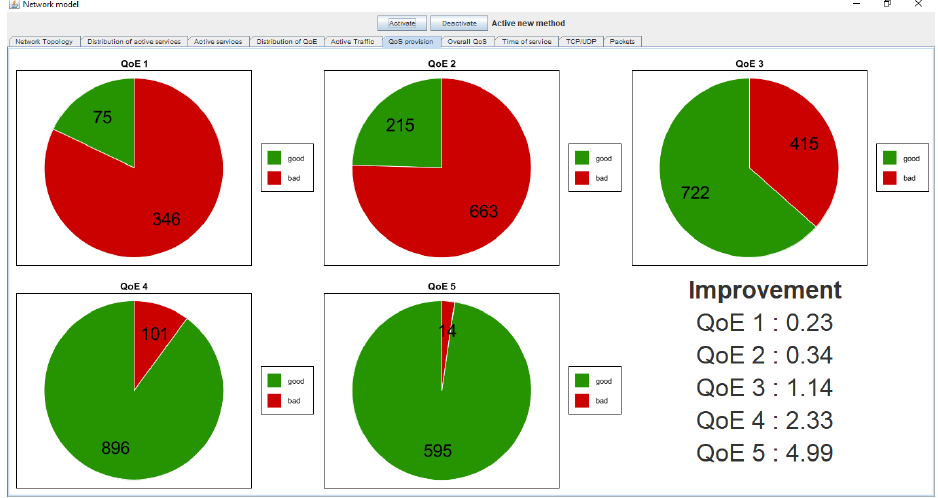
Figure 28. Customers QoE in the network with proposed method. Appl. Sci. 2020 , 10 , x FOR PEER REVIEW